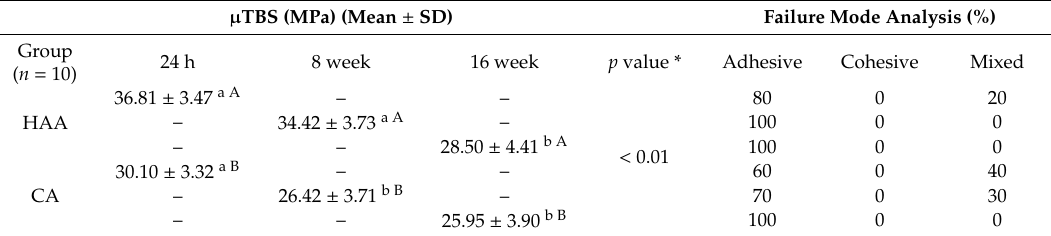
Table 1. Microtensile bond strength (Mean and SD) and failure modes distribution among the investigated